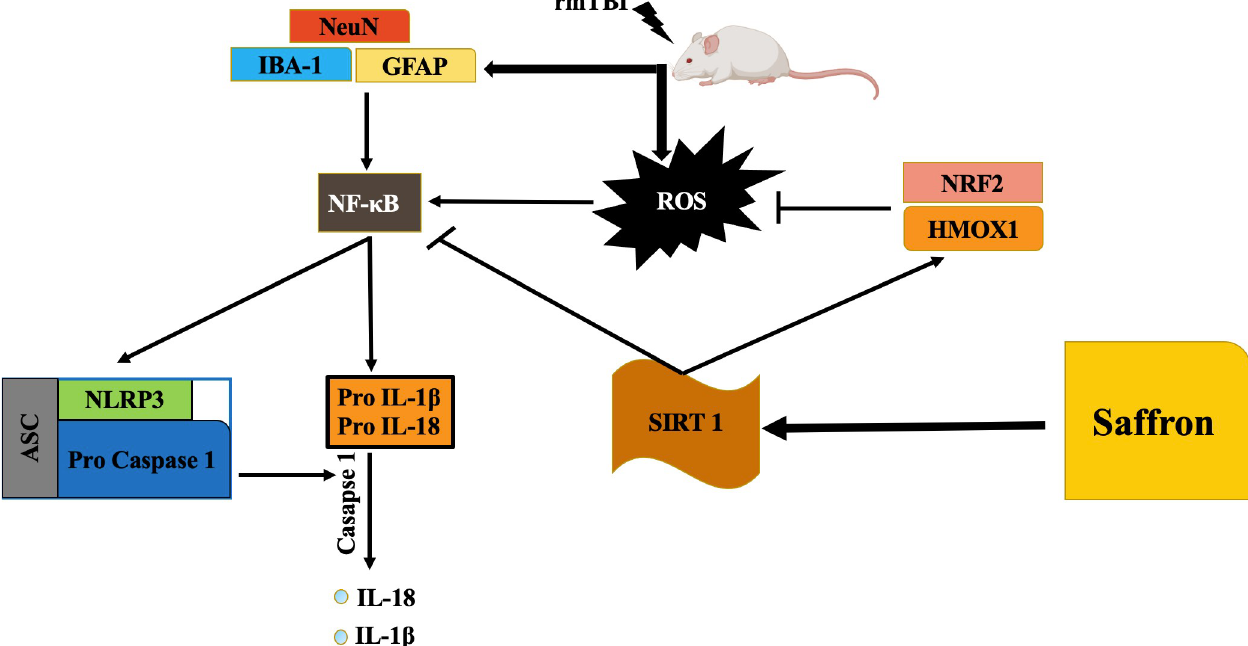
Fig 8. Schematic illustration of saffron attenuating neuronal inflammation and oxidative stress post rmTBI, by suppressing NLRP3 inflammasome activation via SIRT1 activation Abbreviations: ROS, reactive oxygen species; NLRP3, NOD–like receptors (NLR) family pyrin domain containing 3; ASC, apoptosis–associated speck–like protein containing a CARD; NF– κ B, nuclear factor kappa B; IL–1 β , interleukin–1Beta; IL–18, interleukin 18; SIRT1, sirtuin 1; NRF2, nuclear factor erythroid 2–related factor 2; HMOX1, heme oxygenase 1; GFAP, glial fibrillary acidic protein; Iba1, ionized calcium–binding adaptor molecule; Neu N, neuronal nuclei; rmTBI, repetitive mild traumatic brain injury.